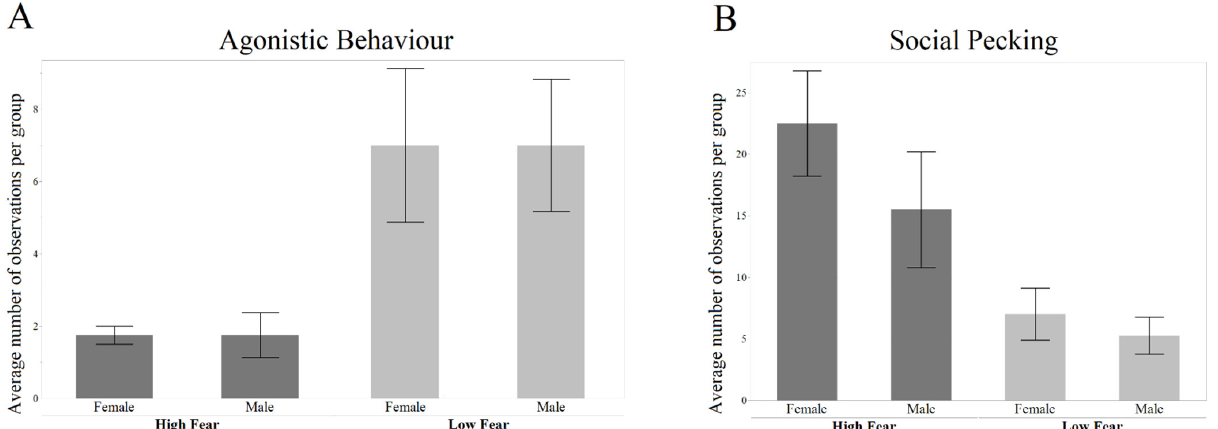
Figure 2. Frequency of agonistic behavior and non-aggressive pecking (mean ± SE). ( A ) Average number of observations per group of agonistic behavior. ( B ) Number of observations of non-aggressive social pecking.